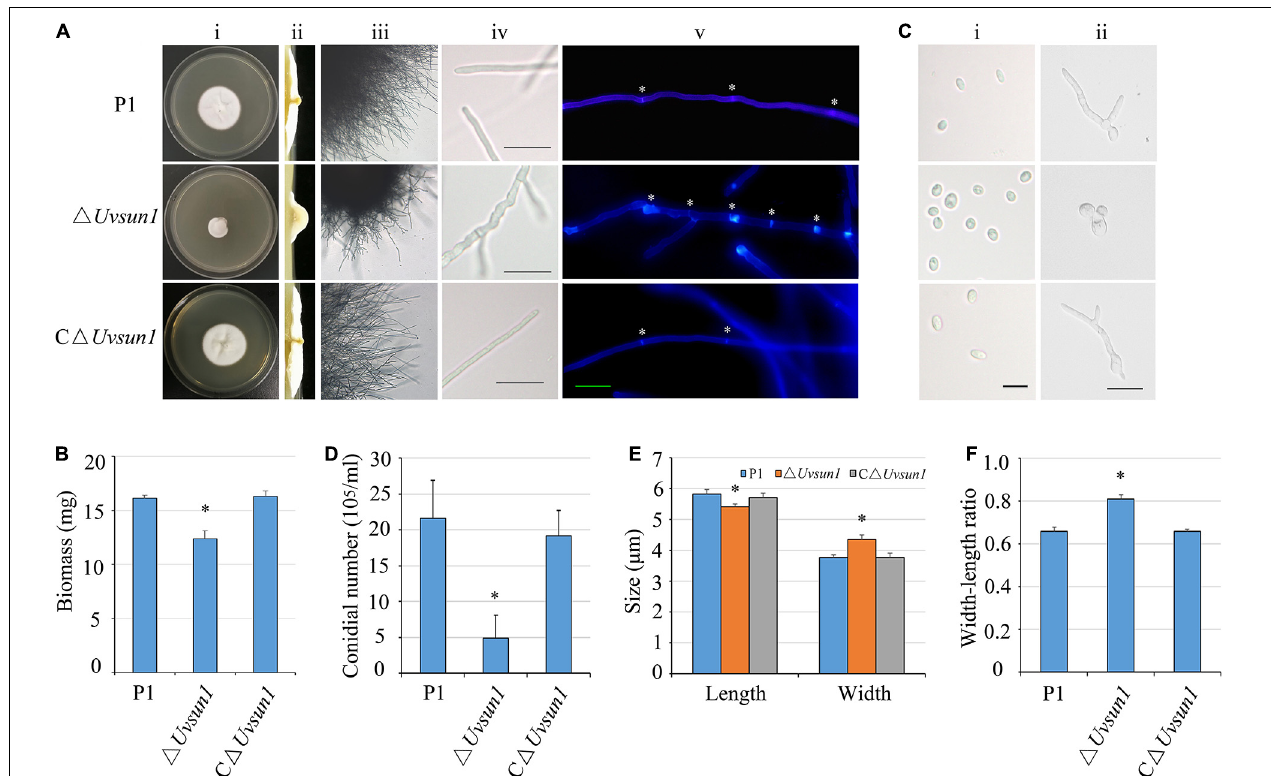
FIGURE 2 | Uvsun1 affects mycelial growth, conidial morphology and production. (A) Colony morphology of wild-type (P1), (cid:77) Uvsun1 deletion mutant and the complemented strain C (cid:77) Uvsun1 on CM medium after 12 days of incubation at 28 ◦ C (i and ii). The mutant strains showed more branched hyphae (iii) and the surface of hyphae expanded irregularly. Scale bars, 20 µ m. (iv). (v) Hyphae of wild-type, mutant and complemented strains were stained with Calcofluor white, which detects chitin and cellulose in the cell wall, and fluorescence is shown in blue color. The hyphal septum of the (cid:77) Uvsun1 mutant was shorter than that of wild type and complemented strains. Asterisk indicate the hyphal septa. Scale bars, 10 µ m. (B) Quantified dry weight of wild type, mutant and the complemented strain. (C) The conidial morphology and germination of wild-type, mutant and the complemented strain were photographed after culturing on YT for 0 h (i) and 24 h (ii). Scale bars, 10 µ m. (D) Statistical analysis of conidia production on YT medium after 7 days culture. Data are shown as mean ± SD from three independent replicates. Asterisks indicate significant differences (one-way ANOVA, ∗ p < 0.05). (E) and (F) The width and length of conidia was statistically analyzed, and error bars represent SD. The asterisks indicate significant differences (one-way ANOVA, ∗ p <